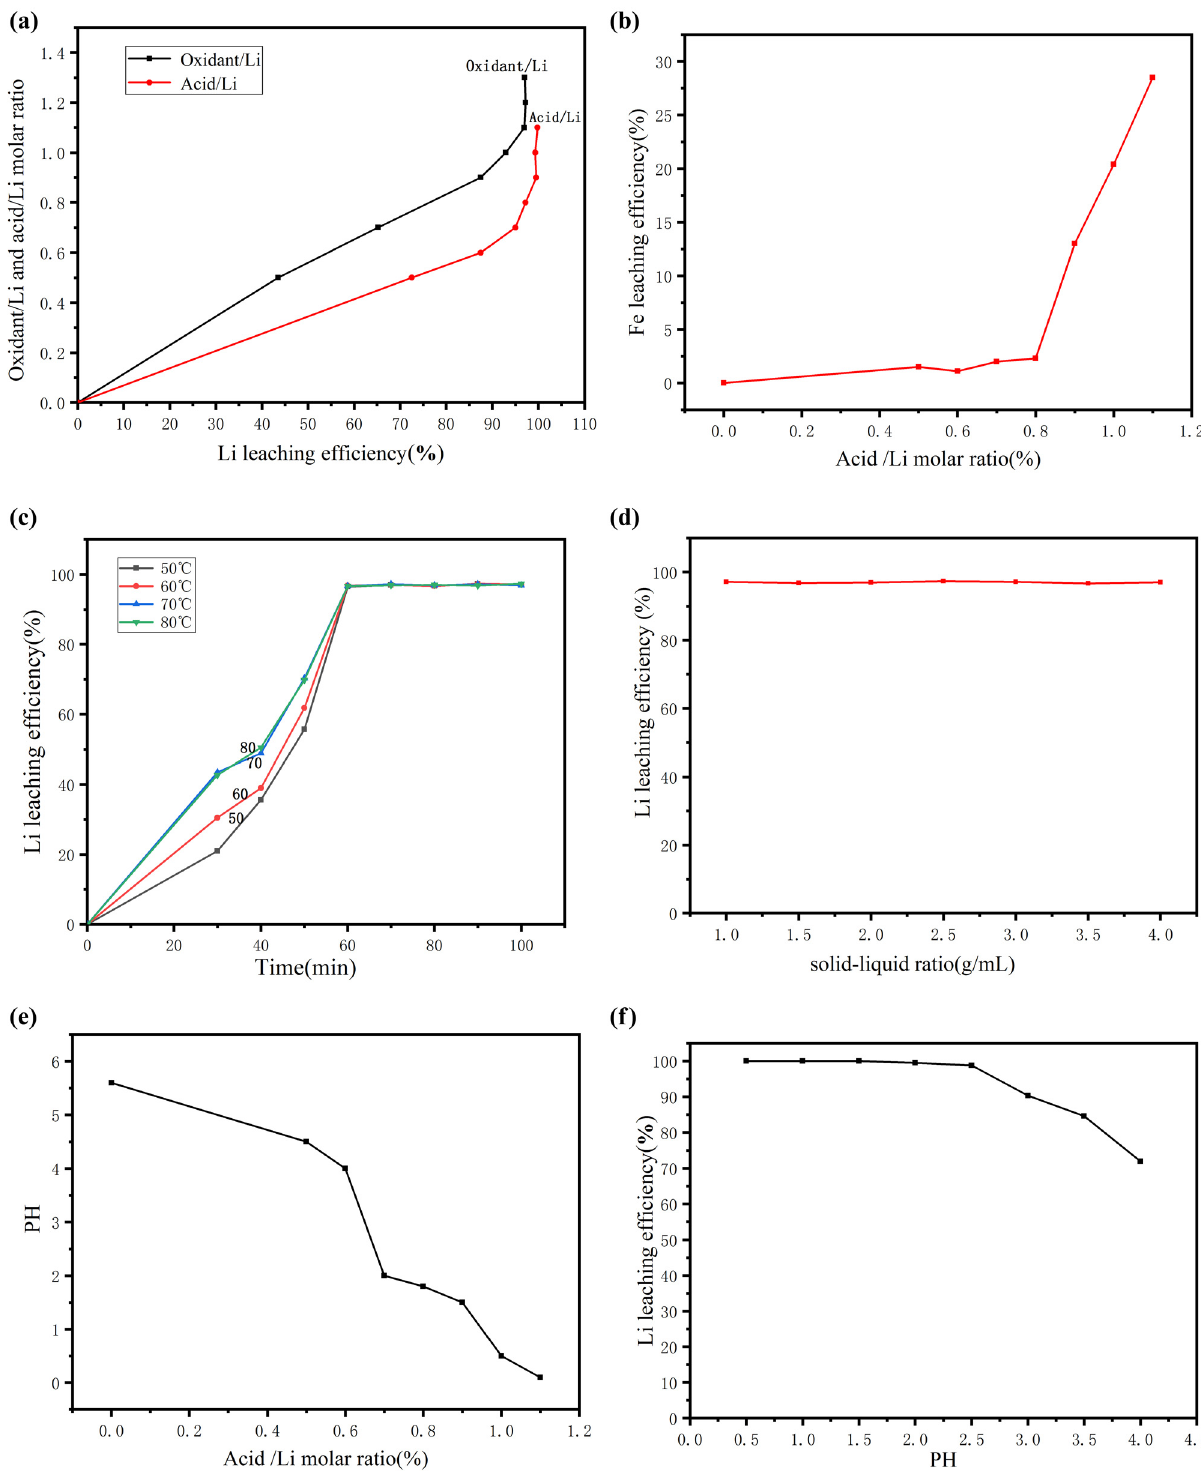
Figure 1: ( a ) Acid and oxidant molar ratios to Li and the impact on leaching e ffi ciency; ( b ) HCl : Li ratio e ff ect on unwanted Fe 3 + leaching; ( c ) Four ( 4 ) temperature condition are plotted against time to measure e ffi ciency showing 60 minutes is optimal for leaching; ( d ) Leaching e ffi ciency against solid – liquid ratio and shows a minimal e ff ect, ( e ) Plot of pH against the HCl/Li molar ratio; ( f ) the relationship between pH of the solution and lithium leaching e ffi